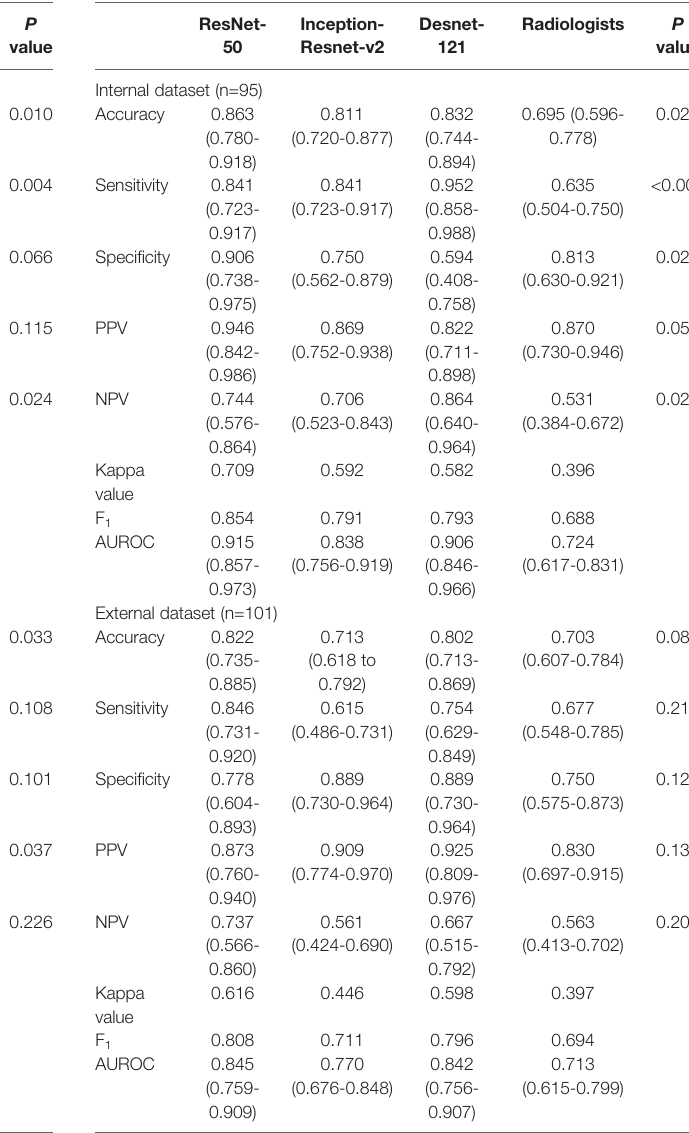
TABLE 3 | Performance of deep learning containing three CNNs compared with the radiologists in differentiating benign and malignant thyroid nodules classi fi ed into ACR TI-RADS category 4.